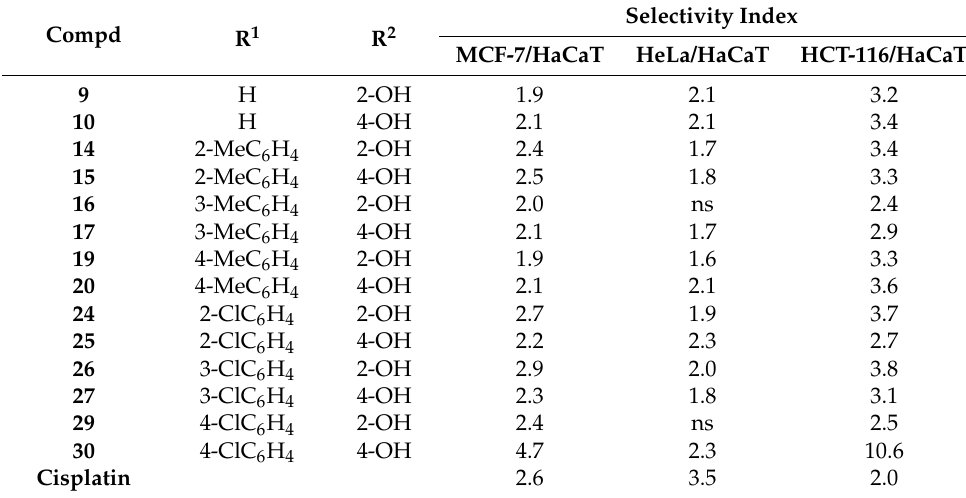
Table 2. The selectivity of the selected compounds 8 – 33 toward cancer cells.